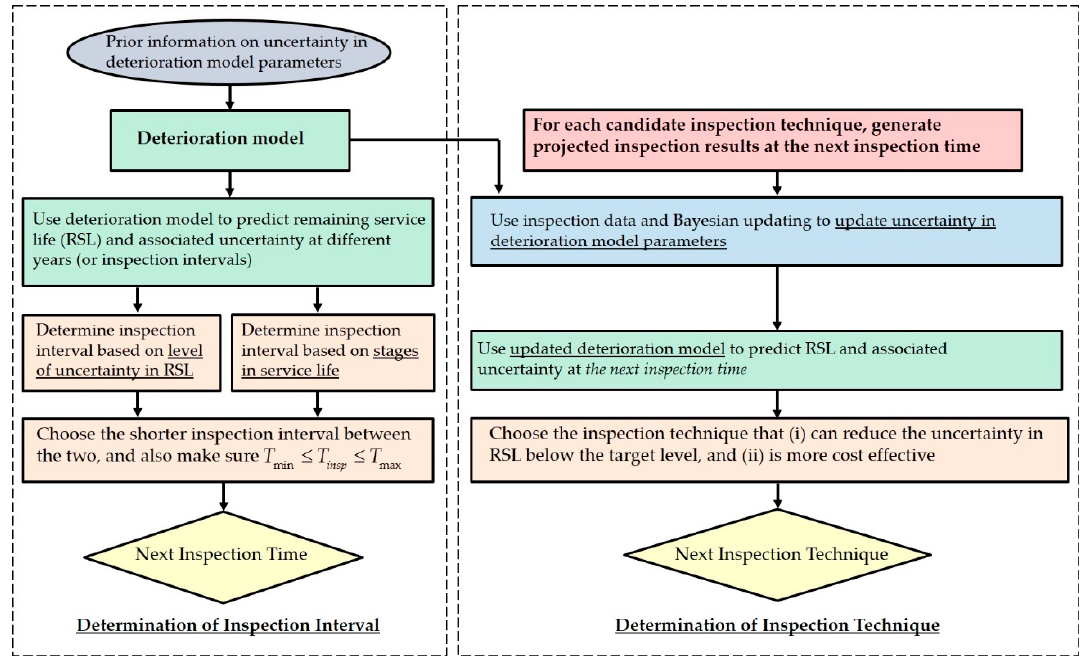
Figure 2. Flowchart of the proposed uncertainty-based inspection decision framework.